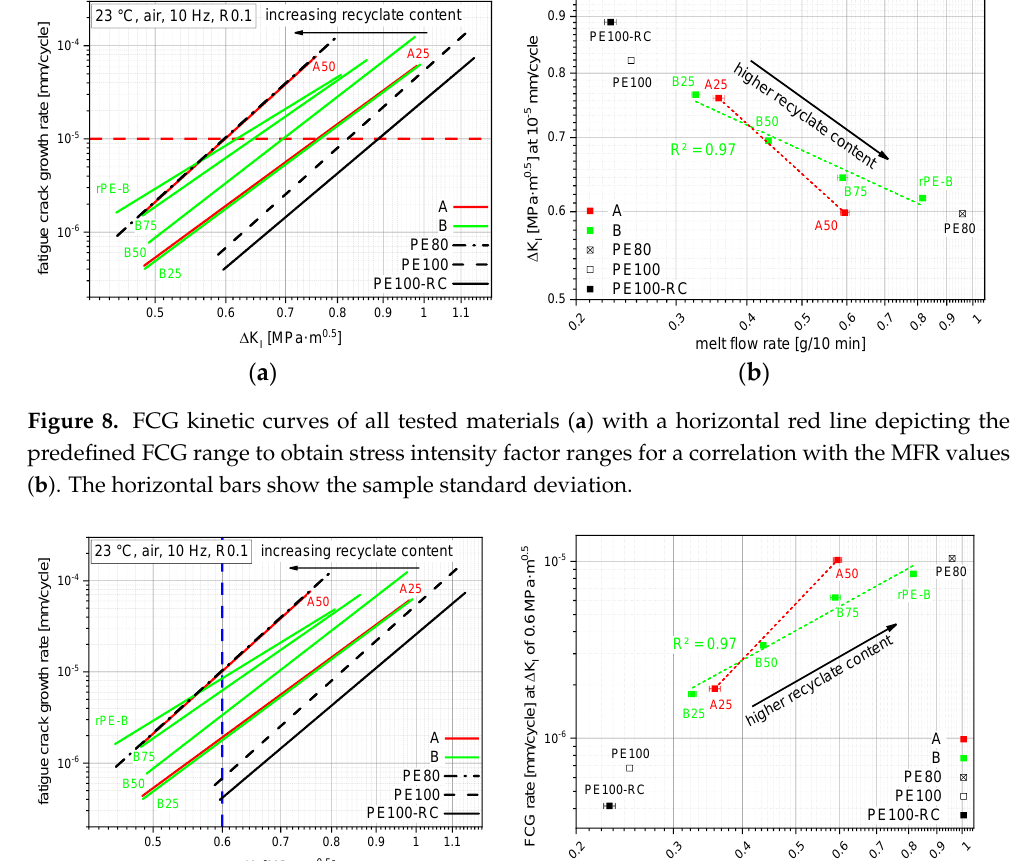
Figure 9. FCG kinetic curves of all tested materials ( a ) with a vertical blue line depicting the predefined stress intensity factor range to obtain FCG rates for a correlation with the MFR values ( b ). The horizontal bars show the sample standard deviation.